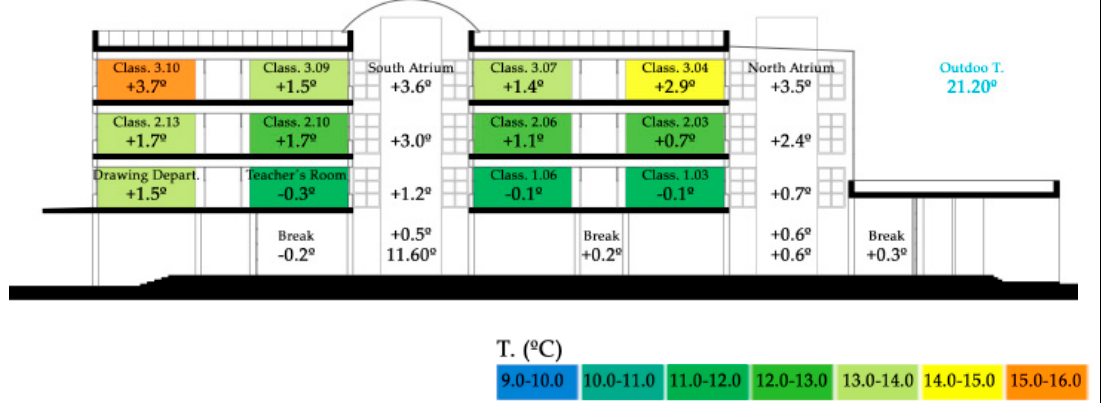
Figure 4. Thermal gaps correlation between classrooms and transitional spaces at 16:00 h (6 January